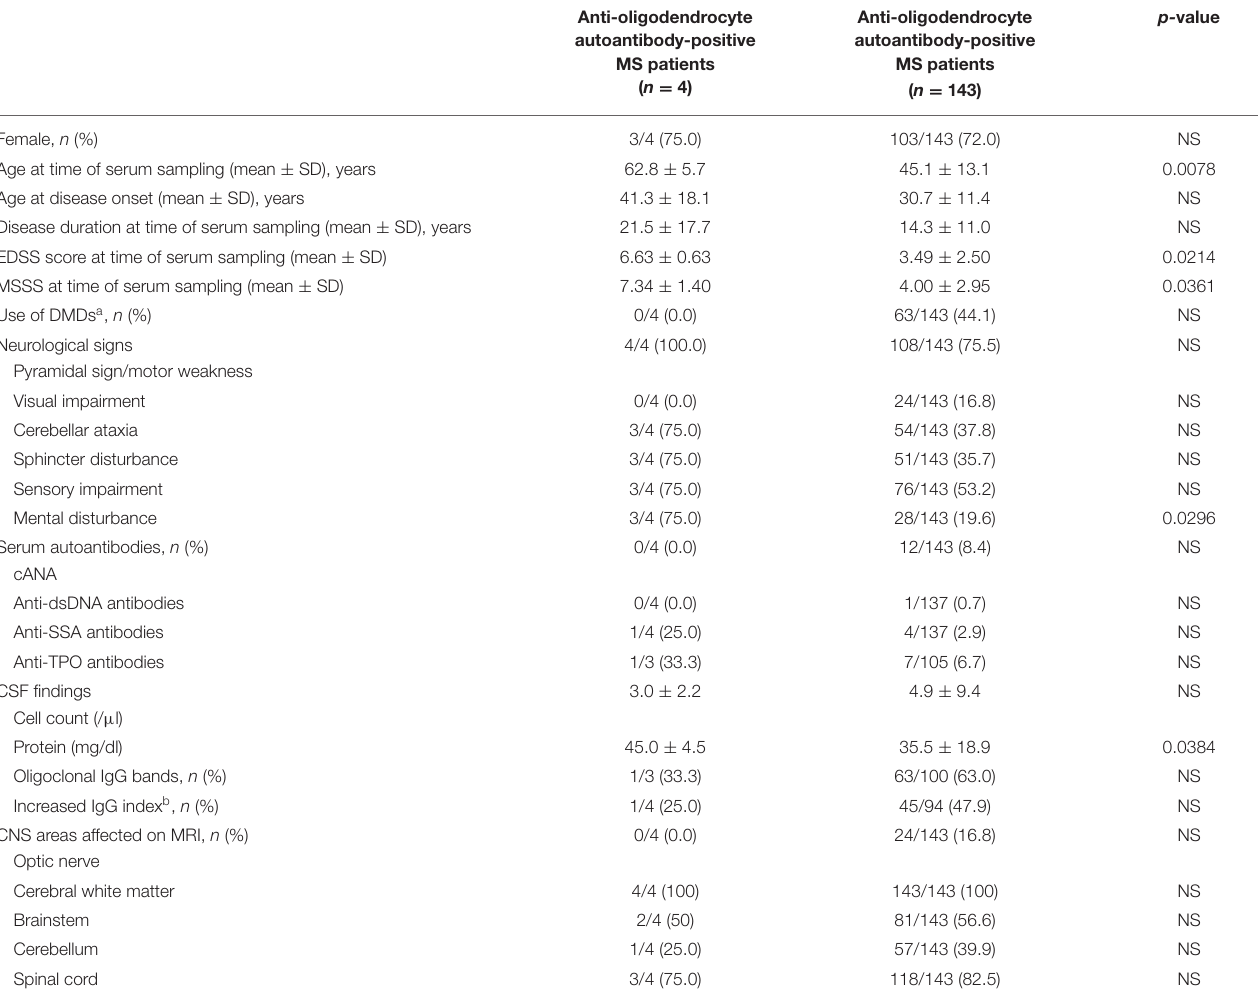
TABLE 3 | Demographic and clinical features in MS patients with and without anti-oligodendrocyte autoantibodies.